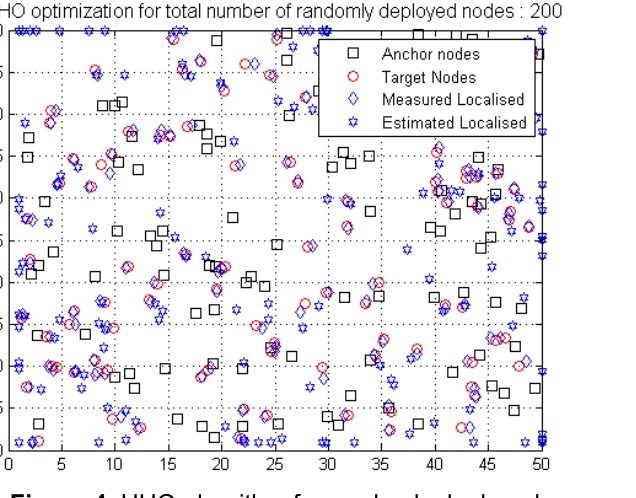
Figure 6. GWO algorithm for randomly deployed sensor nodes located in the target area .